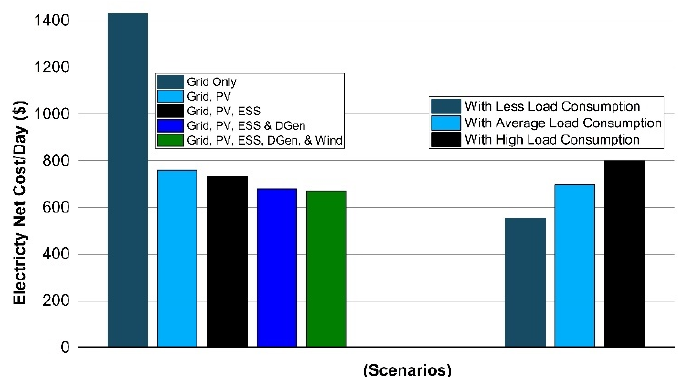
Figure 10. Electricity net cost analysis in multiple scenarios.